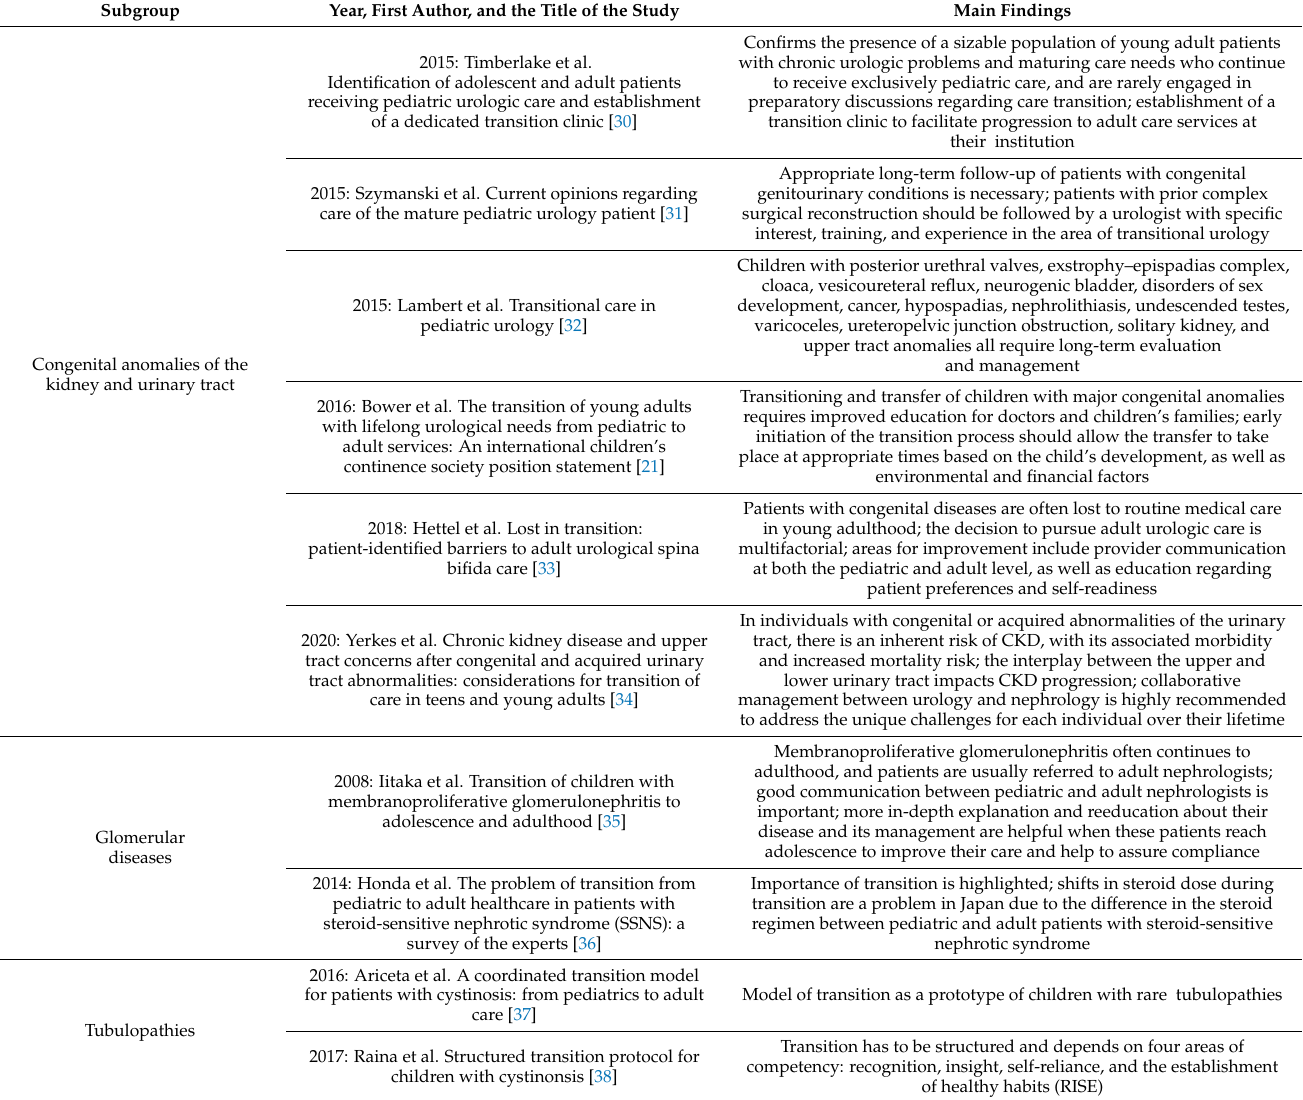
Table 2. Presentation of literature review on transition of chronic pediatric nephrological patients from different fields of risk for chronic kidney disease (CKD)